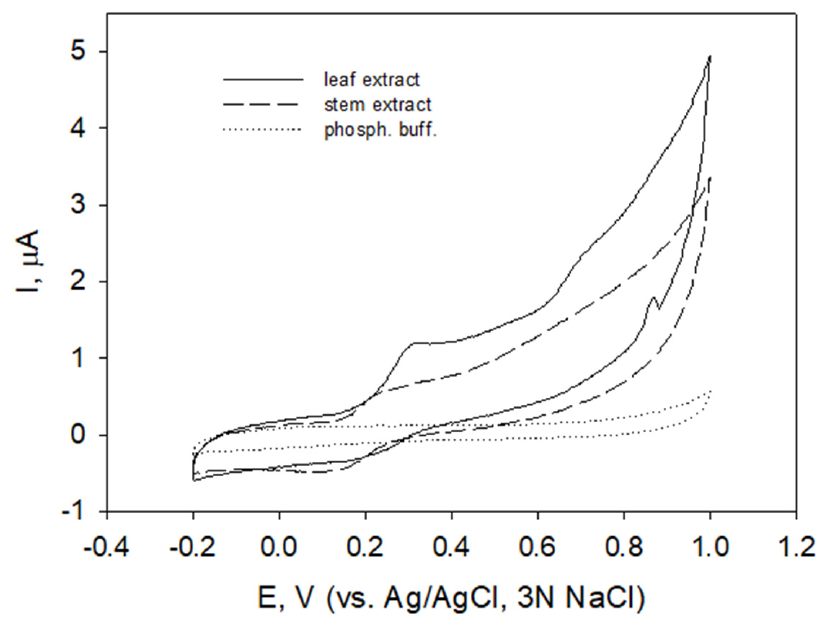
Figure 1. Cyclic voltammograms of carbon paste electrodes in R. idaeus leaf and stem extracts in phosphate buffer pH 6.0 (as indicated), potential scan rate 50 mV/s.